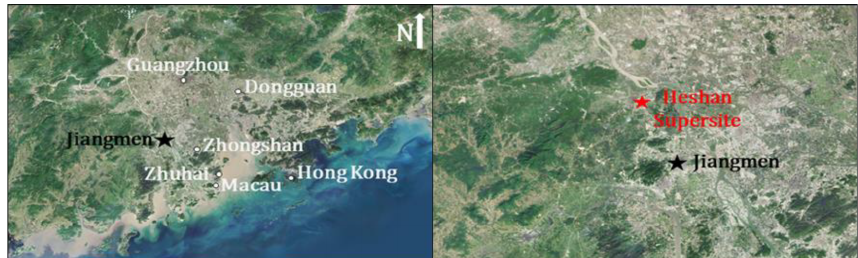
Figure 1. The location of sampling site and its surrounding environment in the Pearl River Delta region. The base map is from © Google